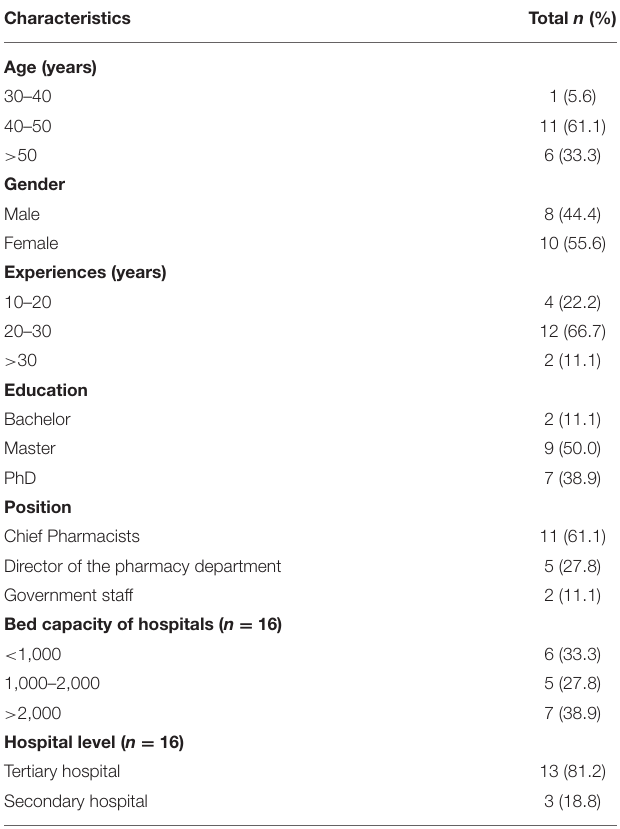
TABLE 1 | Demographic information of participants ( n = 18) and hospitals characteristics ( n = 16).